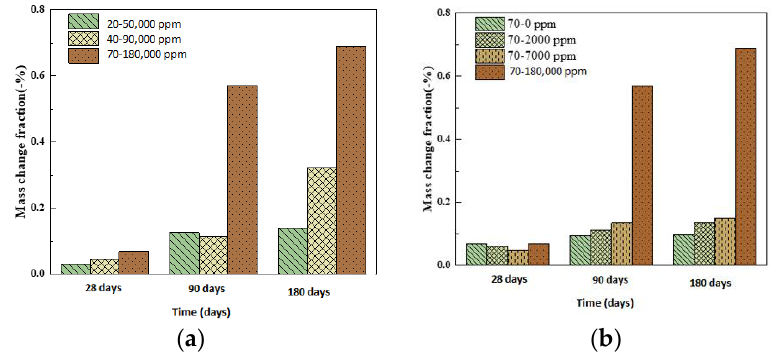
Figure 4. Mass loss of the concrete samples: ( a ) saturation concentration of boric acid; ( b ) 70 °C.